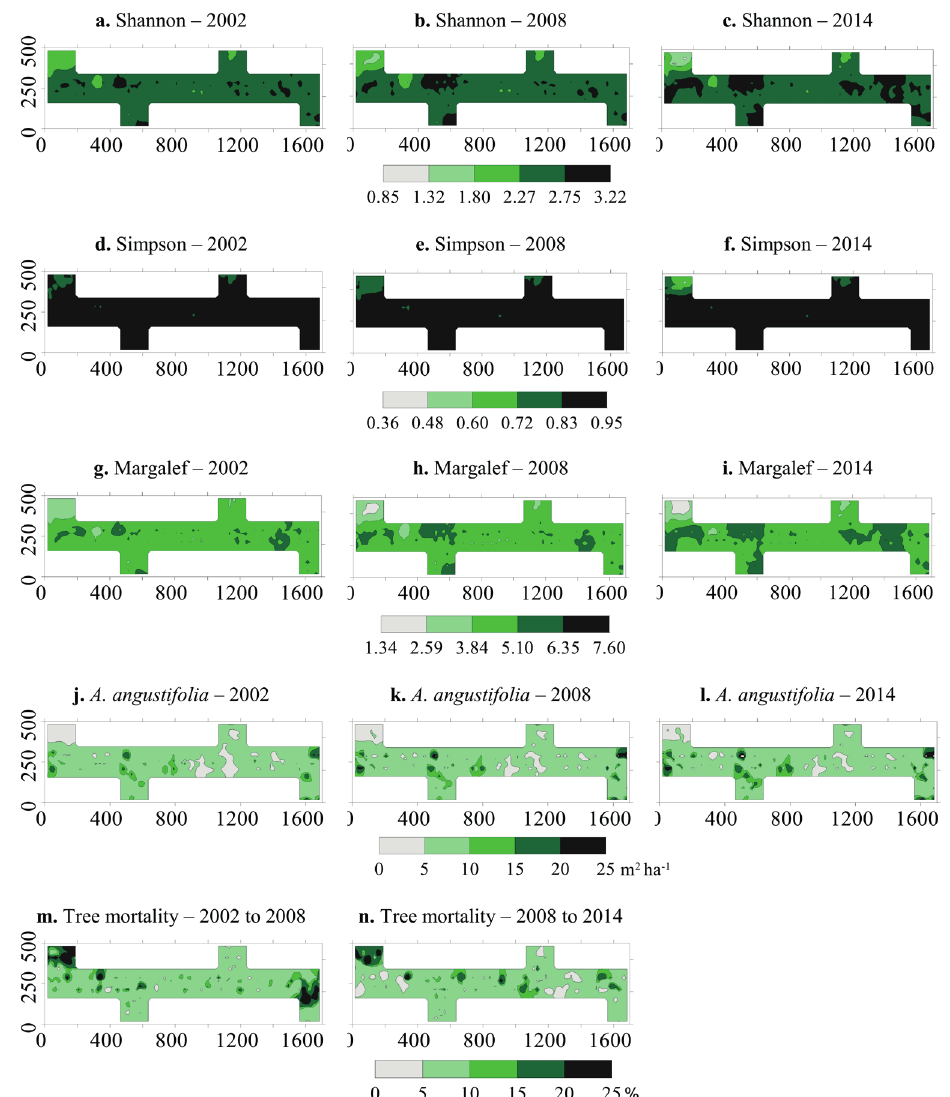
Figure 4 - Maps of Shannon’s index ( a to c ), Simpson’s index ( d to f ), Margalef’s index ( g to i ), Araucaria angustifolia basal area per plot ( j to l ), and annual tree mortality rates per plot ( m , n ) in a mixed tropical forest